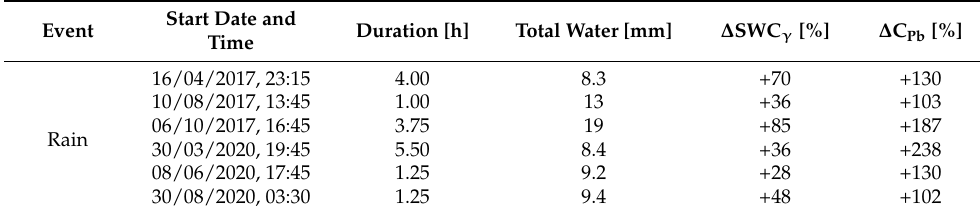
Figure 8. Temporal evolution of SWC γ (in green) and C Pb (in orange) during three rainfalls ( a – c ) and three irrigation events ( d – f ) occurred in M2020. The SWC γ (in green) is hourly estimated, while the C Pb (in orange) and the water amount (in blue for rain and in gray for irrigated water) have a 15 min time resolution. Table 4. Relative variations (in percentage) of C Pb and SWC γ before and after the rains and irrigation episodes shown in Figures 7 and 8, together with their start date and time, duration, and total water precipitated. SWC γ variations are calculated by comparing the average values measured in the 4 h before rain/irrigation and in the 4 h after their end. C Pb variations are calculated considering the 4 h before and the 4 h after rain/irrigation